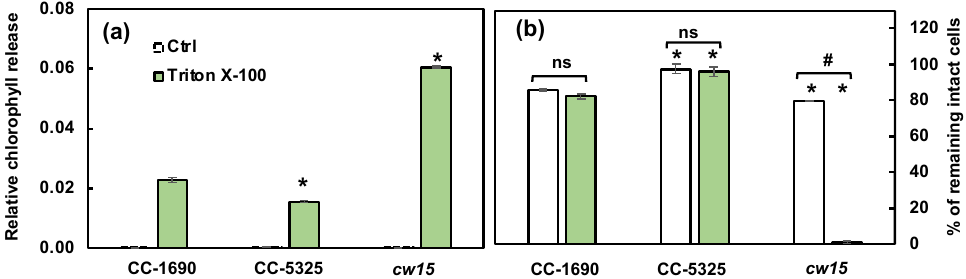
Figure 7. CC-1690 and CC-5325 had comparable resistance to the detergent Triton X-100. Detergent assay was performed to check cell wall integrity. Triton X-100 is a detergent to disrupt lipid-based membranes and cause cells without an intact cell wall to lyse. Algal samples with and without 0.05% Triton X-100 were vortexed vigorously. Strains without intact cell walls will have more broken cells in the presence of Triton X-100 and thus more released chlorophyll than strains with intact cell walls. ( a ) Released chlorophyll from damaged cells was quantified using absorbance at 435 nm. ( b ) The percentage of intact cells was quantified using a Coulter Counter. Mean ± SE, N = 3 biological replicates. Statistical analyses were performed using a two-tailed t -test assuming unequal variance by comparing with CC-1690 under the same experimental conditions (*, p < 0.05) or within the same strain in the presence or absence of Triton X-100 (#, p < 0.05; ns, not significant, p >